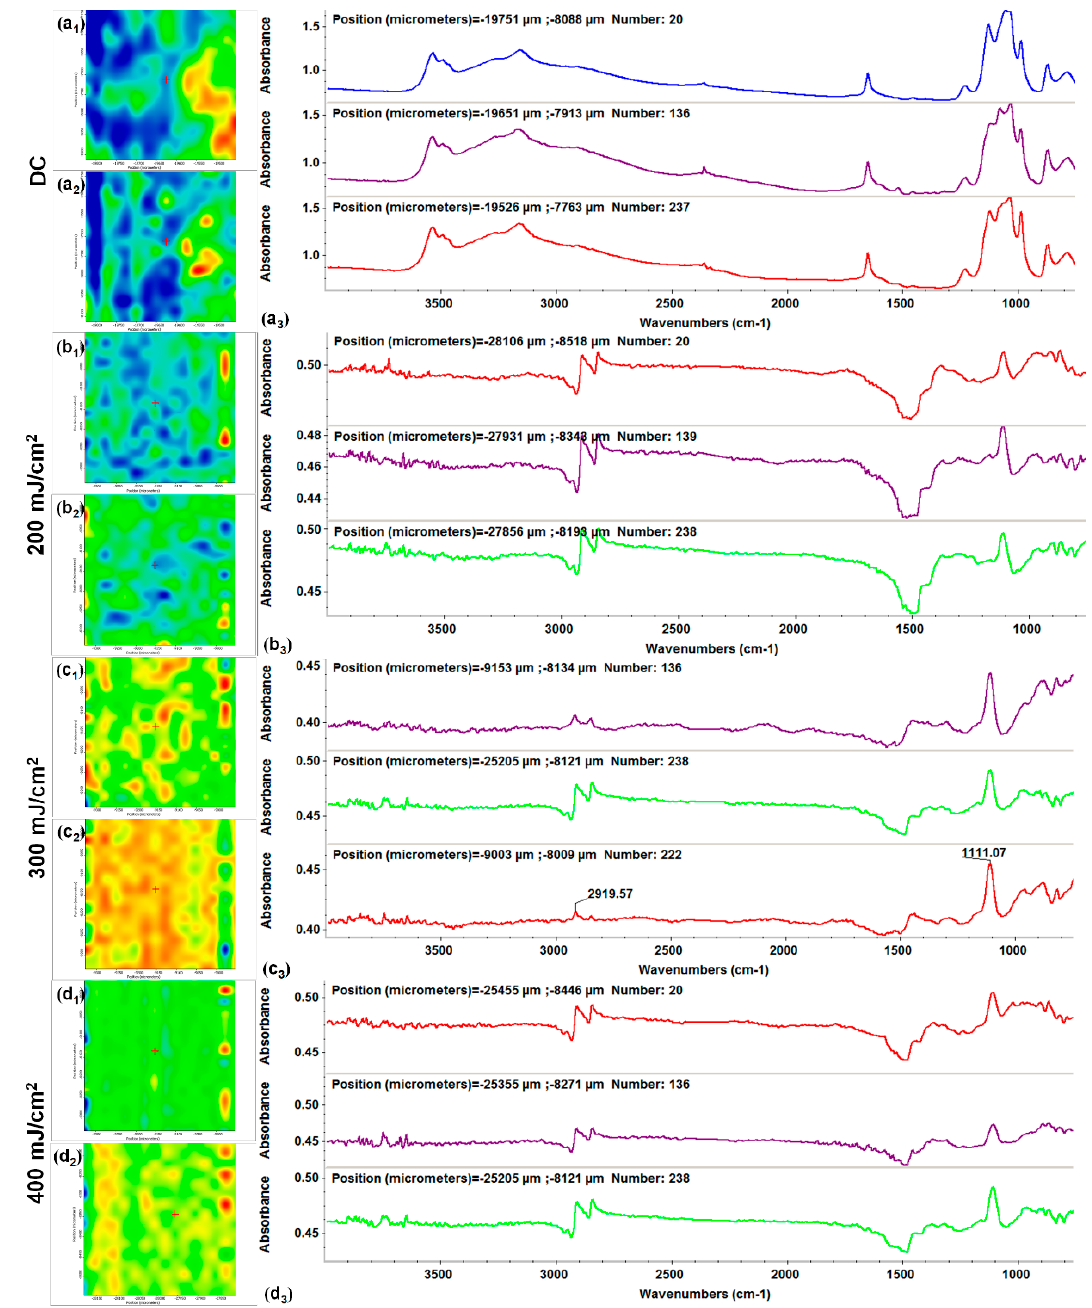
Figure 3. IR maps assigned to the distribution of methylene ( a 1 , b 1 , c 1, d 1 ) and phosphate ( a 2 , b 2 , c 2 , d 2 ) groups and IR spectra of dropcast ( a 3 ) and HAp/KAN (Kanamycin) coatings obtained at 200 ( b 3 ), 300 ( c 3 ) and 400 ( d 3 ) mJ/cm 2 laser